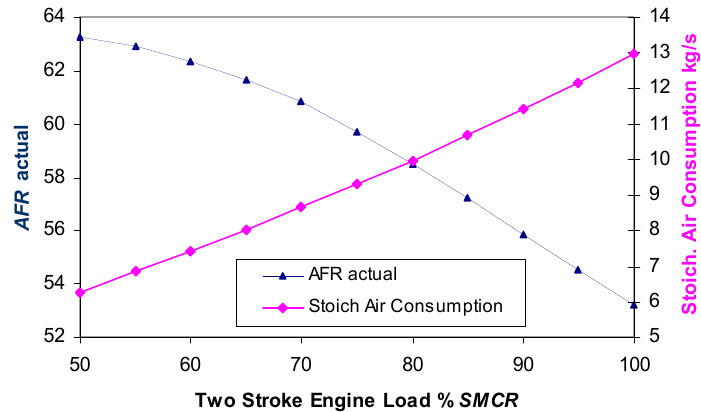
Figure 6. AFR actual and stoichiometric air consumption in the function of main engine load.